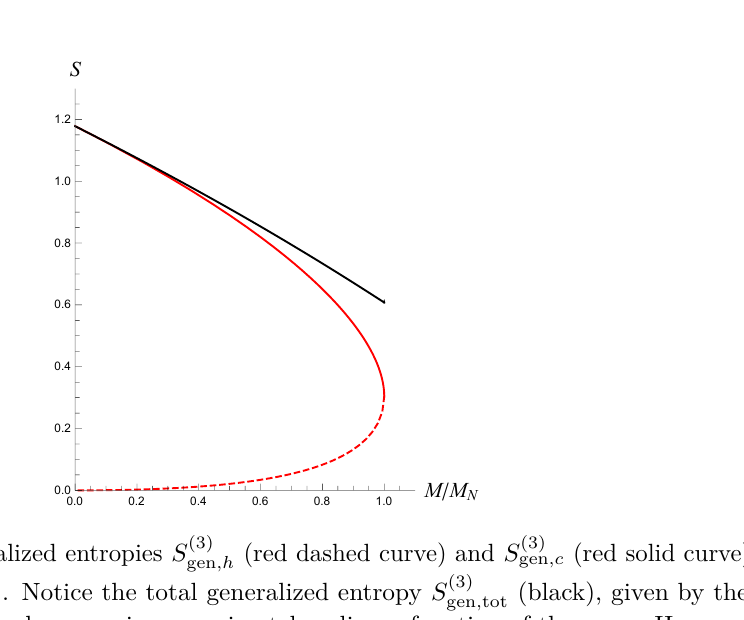
Figure 9 . Plot of generalized entropies S (3) function of M = M/M N . Notice the total generalized entropy S (3) of the red solid and dashed curves, is approximately a linear function of the mass. Here we have set ν = 1 / 3